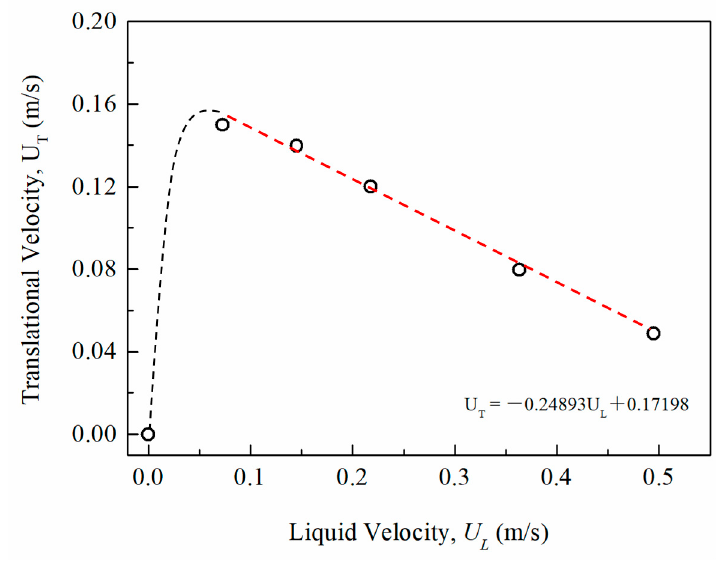
Figure 23. U T as a function of U L for 48.5 lb/bbl BW at 4 ◦ Figure 23. (cid:1847) (cid:3021) as a function of (cid:1847) (cid:3013) for 48.5 lb/bbl BW at 4°.